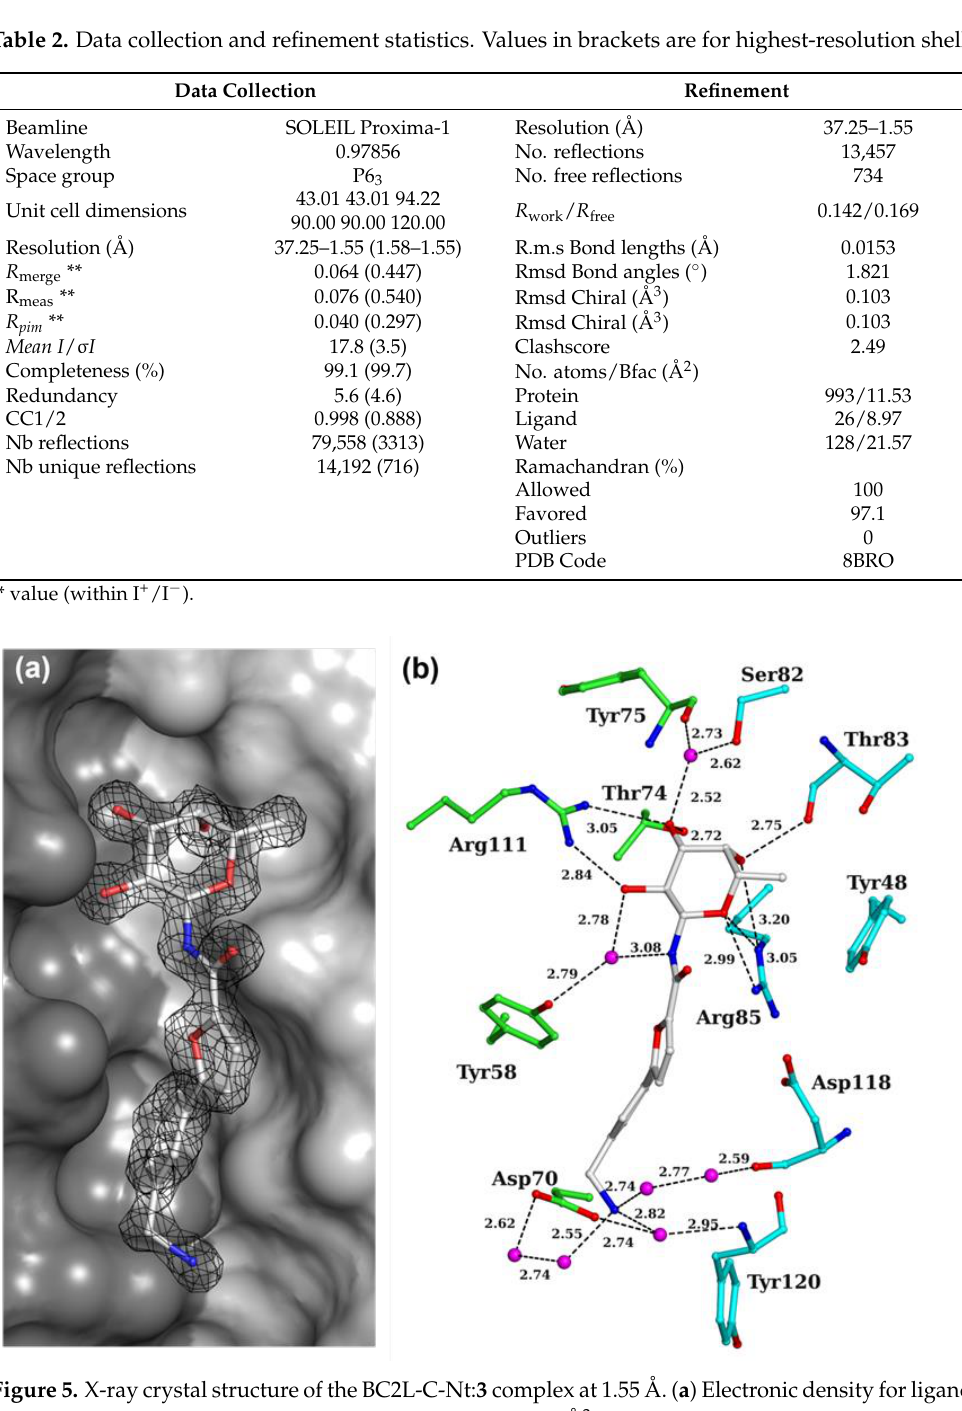
Figure 5. X-ray crystal structure of the BC2L-C-Nt: 3 complex at 1.55 Å. ( a ) Electronic density for ligand 3 in complex with BC2L-C-Nt represented at 1.3 σ (0.71 eÅ 3 ). ( b ) Atomic detail of the interactions of 3 with BC2L-C-Nt (PDB ID 8BRO). Water molecules are depicted as purple spheres and direct or water-mediated hydrogen bonds are shown in black dashes. Protein carbon atoms are colored according to protomers.